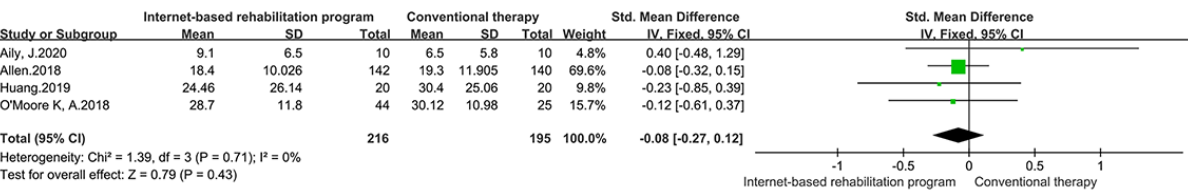
Figure 3. Forest plot of included studies comparing the effect of the internet-based intervention and conventional rehabilitation on physical function based on the Western Ontario and McMaster Universities Osteoarthritis (WOMAC) function